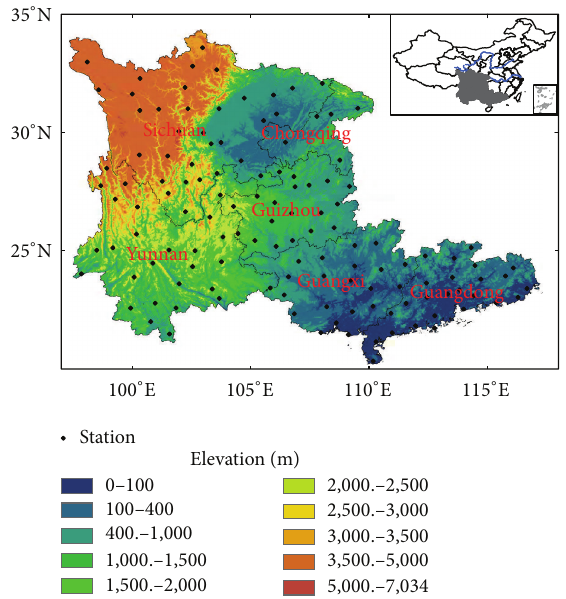
Figure 1: The location of southwestern and southern areas in China, thespatialdistributionofelevation(unit:m),and124meteorological stations (dot) in the study